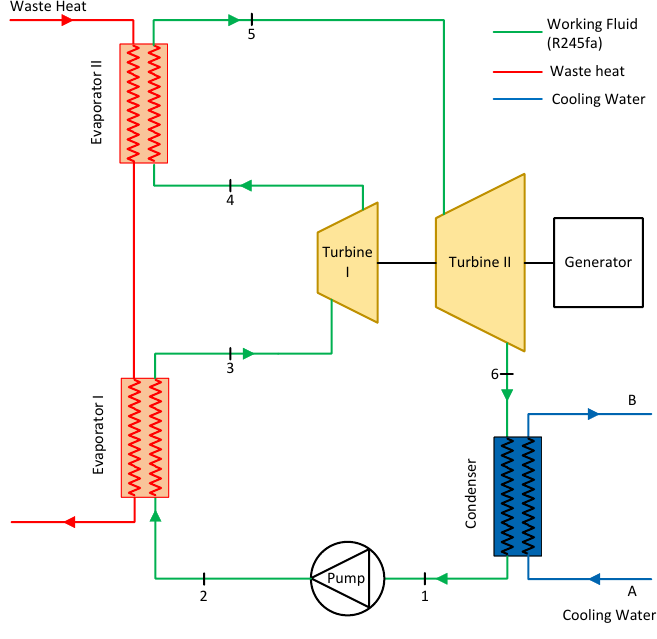
Fig. 4. ORC setup used in the thermodynamic